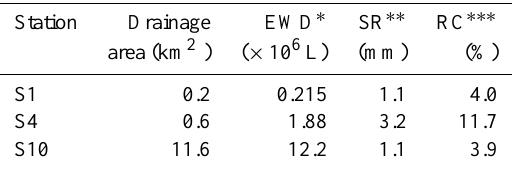
Table 1. Estimates of event water discharge (EWD) and related spe- cific runoff (SR) and runoff coefficient (RC) for the three stations during the 23 May 2012